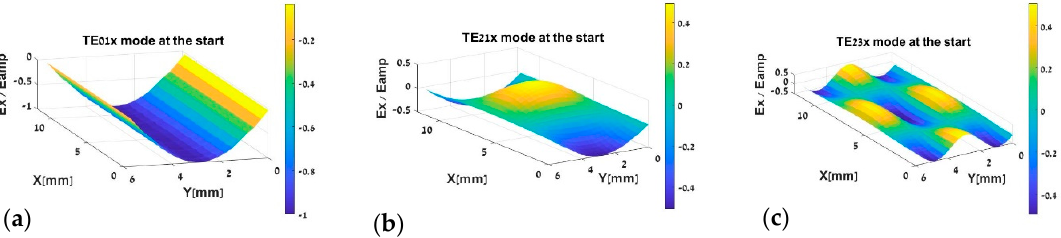
Figure 4. The Ex field at the waveguide output: ( a ) TE 01 mode; ( b ) TE 21 , and ( c ) TE 23 modes. Note: In this case for a convenience, the EM field is in the − 180° time phase at the output of the waveguide at zero moment. Therefore, is each mode respectively. For convenience, each mode is displayed in a normalized form. When Eamp is calculated by following form: Eamp = Ex MAX − Ex MIN.